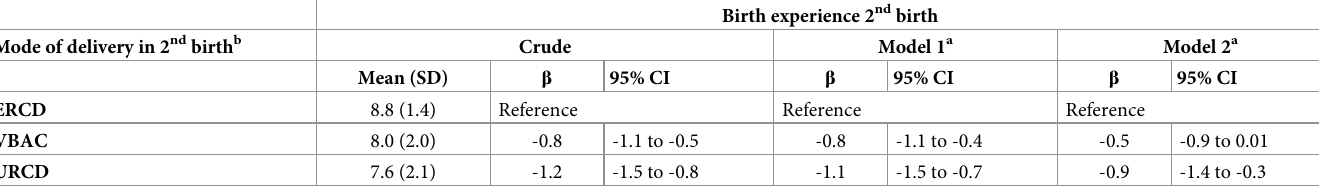
Table 2. Mean difference of birth experience by mode of delivery in 2 nd birth, linear regression.